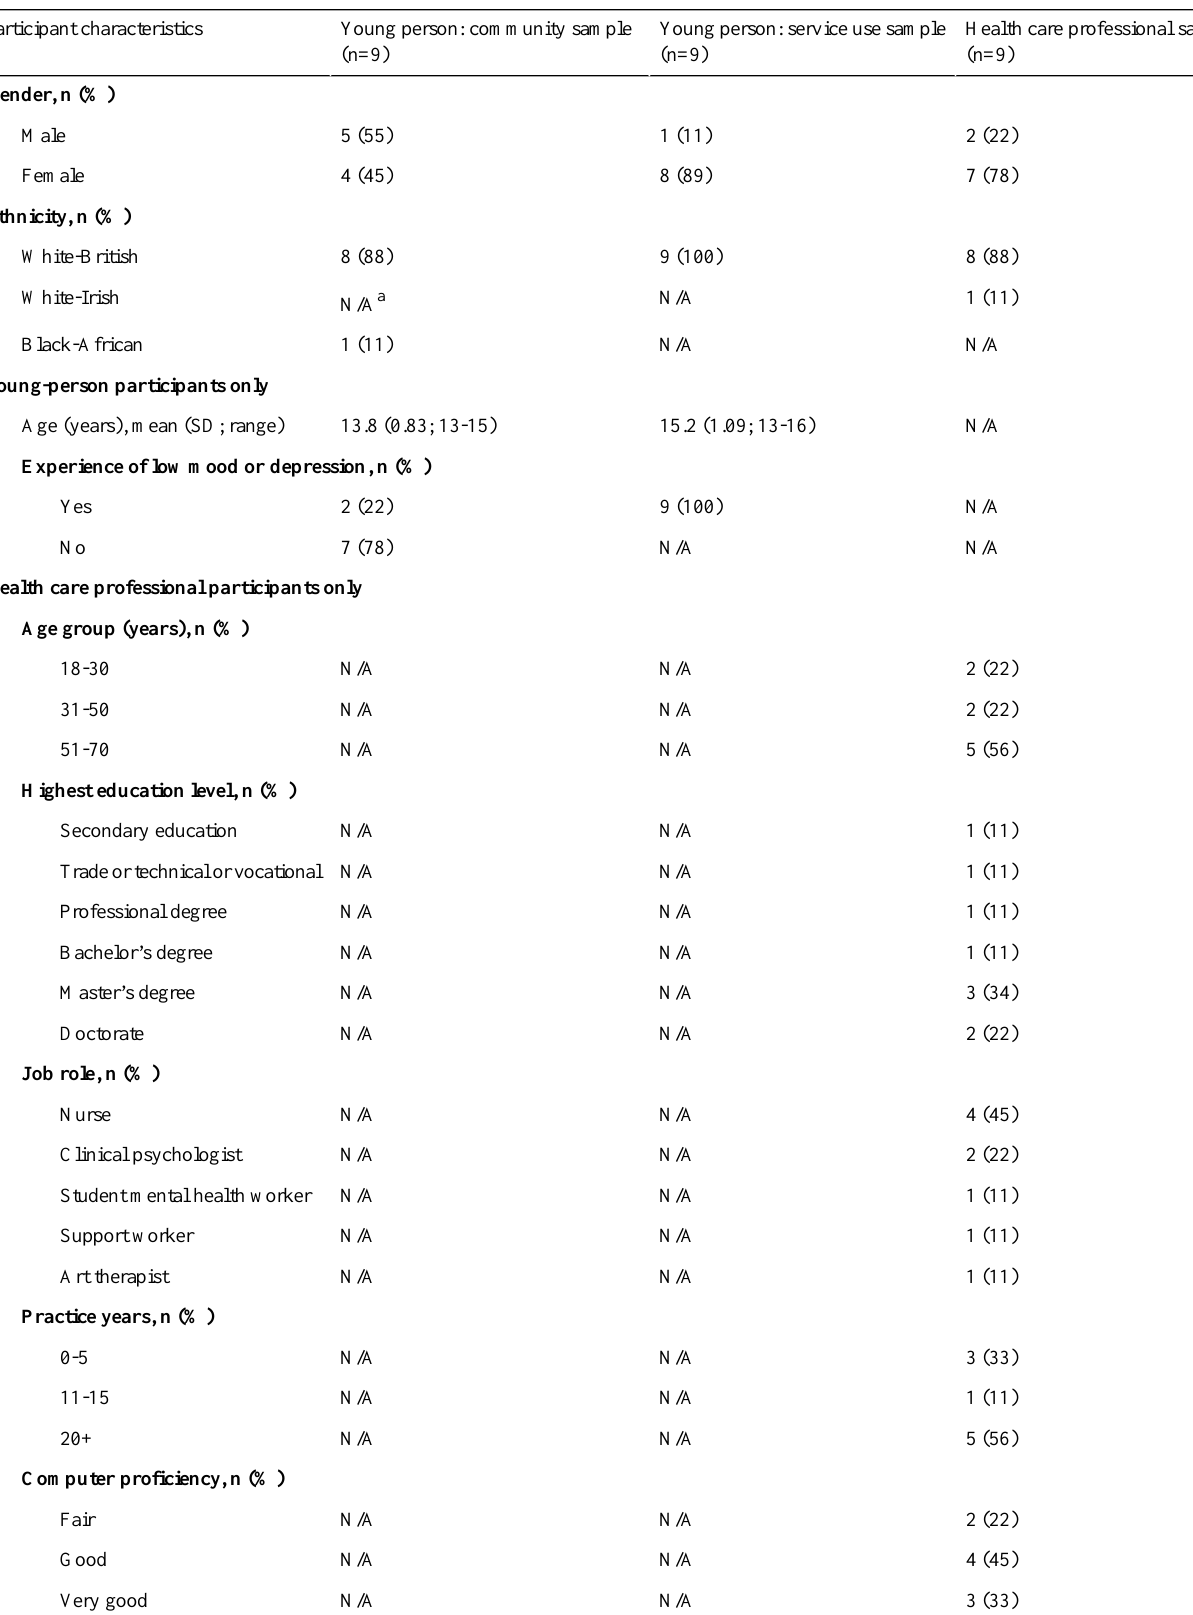
Table 1. Participant sample characteristics